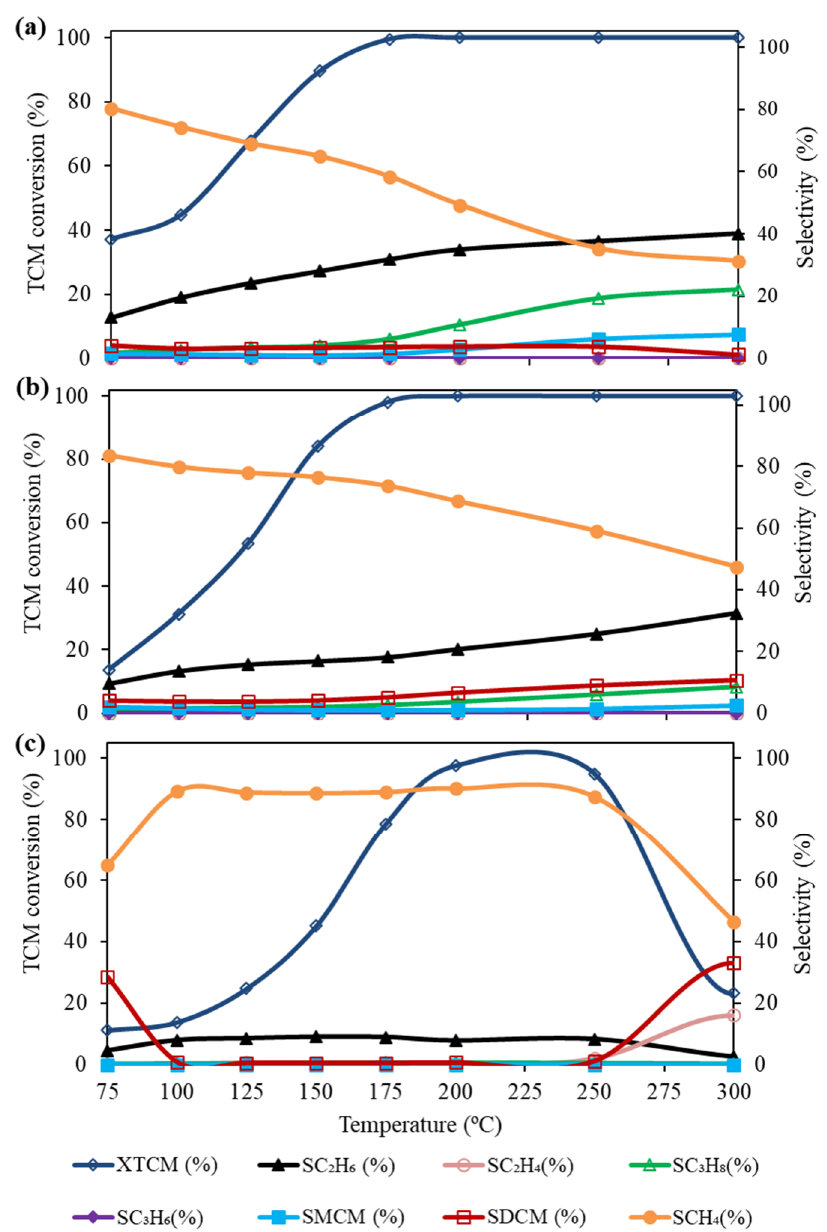
Figure 9. Conversion of TCM, X TCM , and selectivities, S, to the products indicated, as a function of temperature for the catalysts: ( a ) IW-Pd; ( b ) DS-Pd and ( c ) SL-Pd.